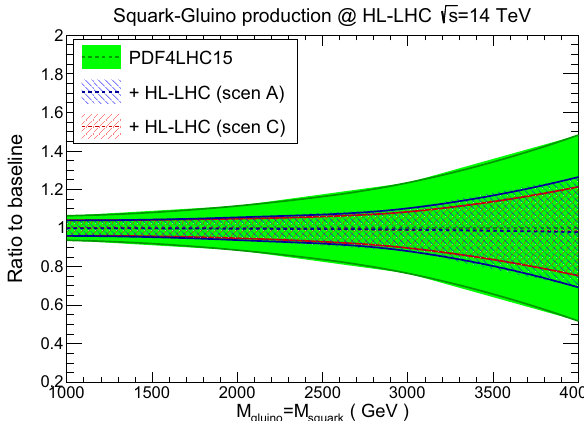
Fig. 20 Thecrosssectionsforhigh–masssupersymmetricparticlepro- √ s = 14 TeV, comparing the predictions of the PDF4LHC15 duction at baseline with those of the HL–LHC PDF sets in the conservative (A) and optimistic (C) scenarios, normalised to the central value of